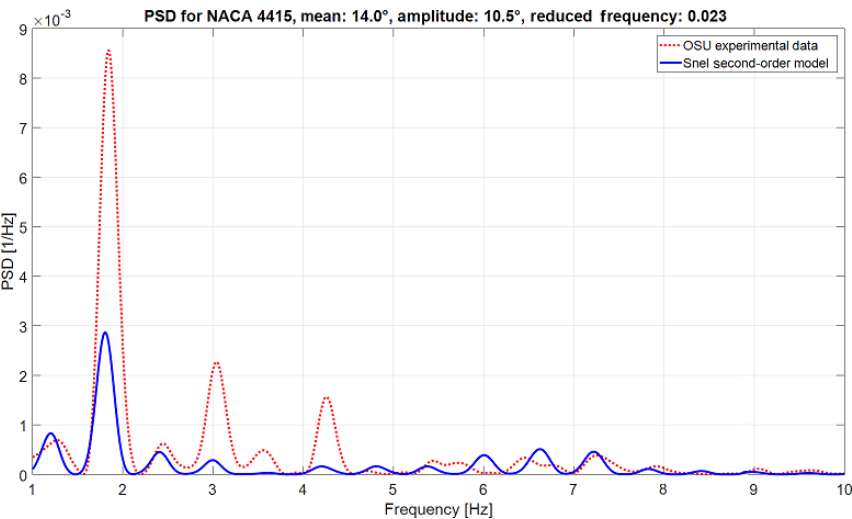
Figure 10. Power spectral density of experimental data and the improved Snel model (NACA 4415 aerofoil mean angle of attack of 14 ◦ , amplitude of 10.5 ◦ , and reduced frequency of 0.023).